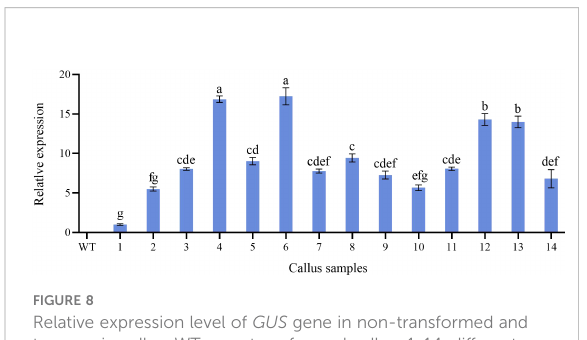
FIGURE 8 Relative expression level of GUS gene in non-transformed and transgenic callus. WT, non-transformed callus; 1-14, different transgenic callus, the different letters within a column marked signi fi cant differences (p <